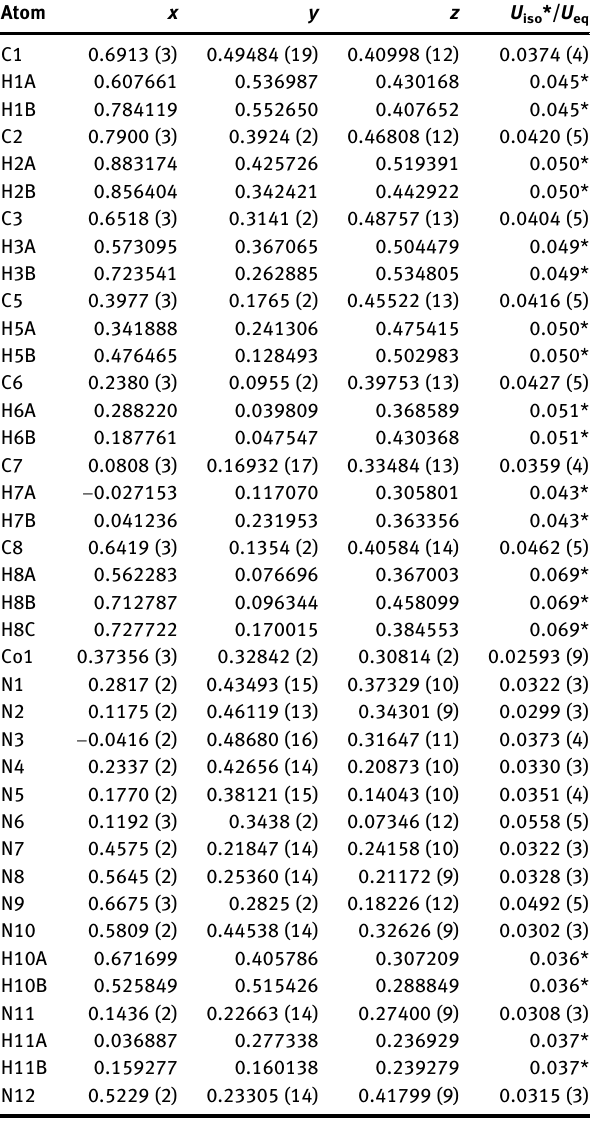
Table  : Fractional atomic coordinates and isotropic or equivalent isotropic displacement parameters (Å 